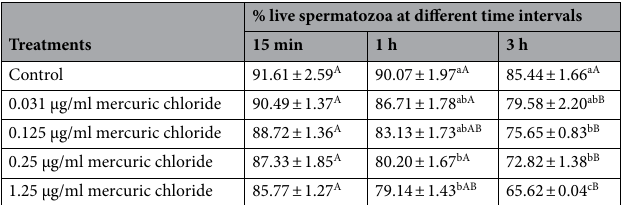
Table 2. Effect of in‑vitro exposure of spermatozoa to different concentrations of mercuric chloride (0.031– 1.25 µg/ml) on live spermatozoa count at different time intervals. Data presented are mean ± SE of the semen samples of six bucks. Different capital superscripts in the rows indicate significant (p < 0.05) differences between the different time intervals. Different small superscripts in the columns indicate significant (p < 0.05) differences between the different treatment groups.